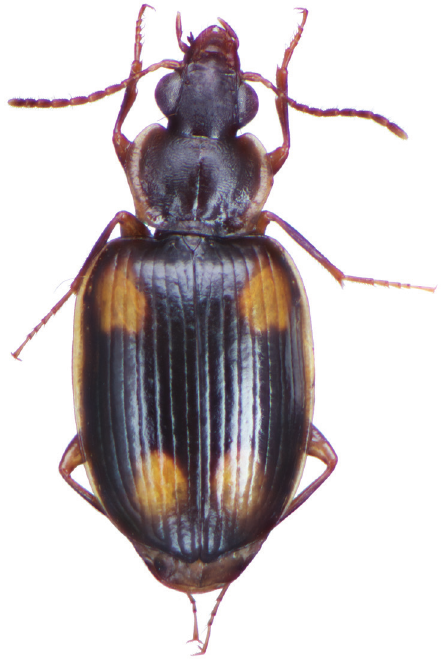
Figure 67. Dorsal habitus and color pattern of Dolichoctis rotundata (Schmidt - Goebel). (OBL 4.72 mm). Body proportions . HW/HL 1.73 – 2.08; PWM/PL 1.50 – 1.89; EL/EW 1.25 – 1.43; ML/MW 1.45 – 1.80. Color . Fig. 67. Dorsum of head brunneous to rufo-piceous, clypeus and